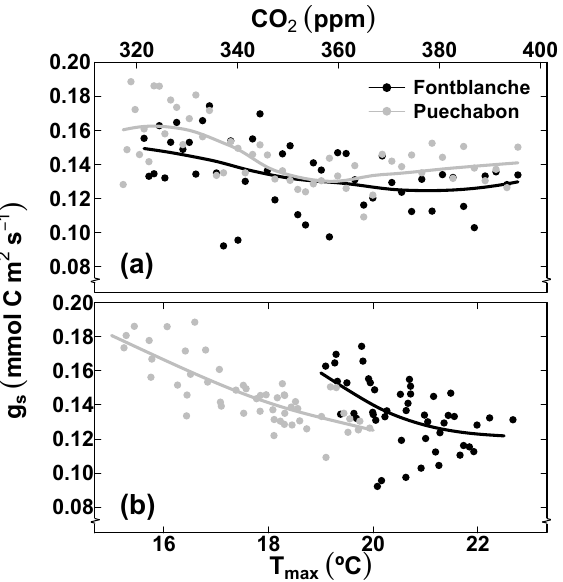
Figure A4. Simulated mean annual stomatal conductance ( g s ) as a function of mean [CO 2 ] (a) and mean maximum temperature (b)